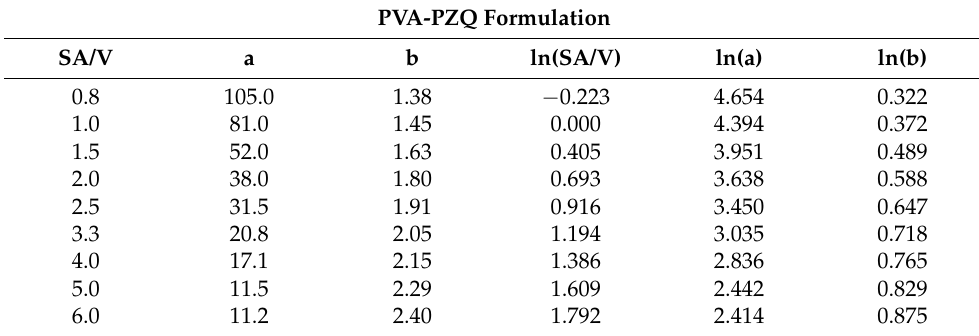
Table 9. Calculated constants for the SA/V ratios of the BCS